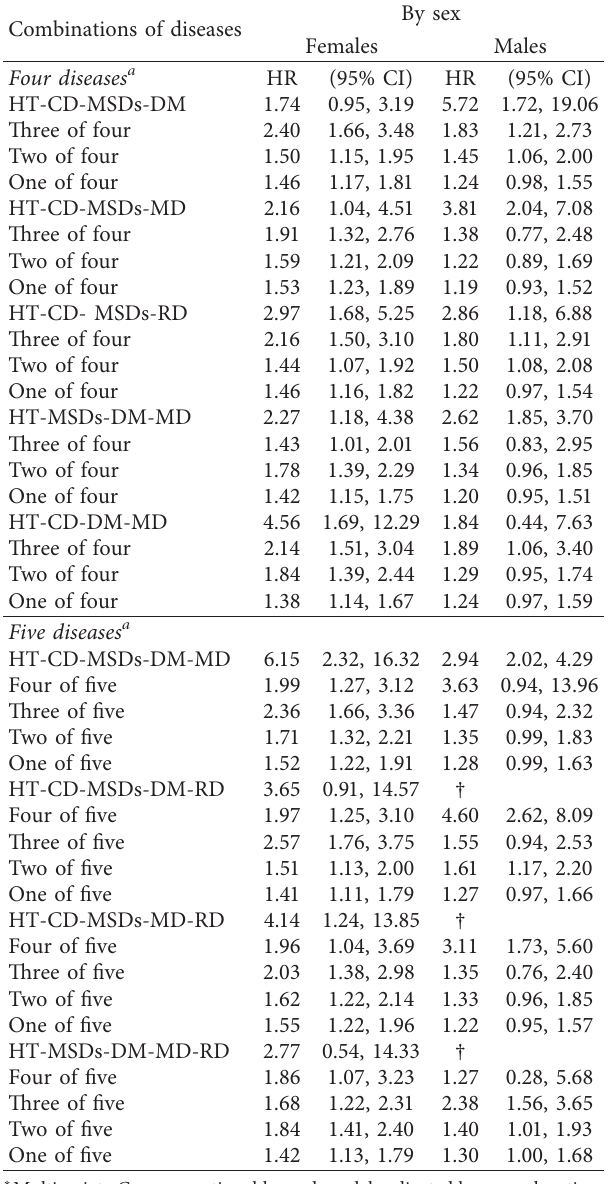
Table 5: Adjusted hazard ratios ∗ (95% Confidence intervals) for all-cause mortality according to combinations of four and five chronic diseases by sex (SABE study, municipality of São Paulo,